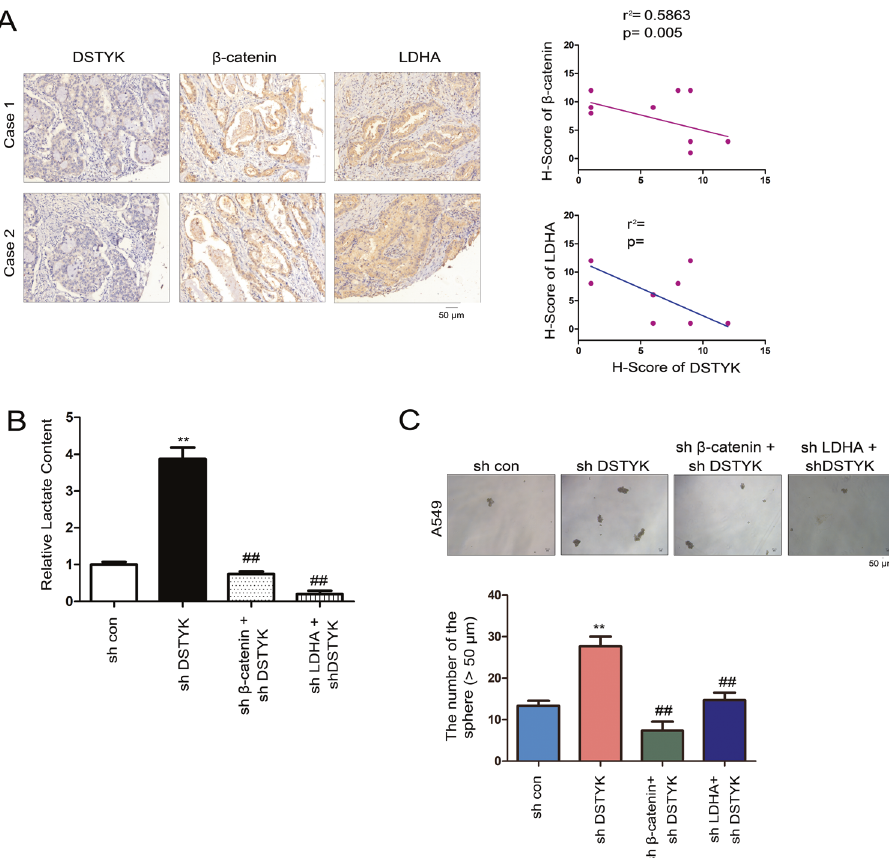
Fig. 7 DSTYK/Wnt/ β -catenin signaling regulated LDHA expression. A The correlation between DSTYK, β -catenin and LDHA in clinical lung tissues. The protein levels of DSTYK, β -catenin and LDHA in 10 lung cancer tissues were examined. The immunostaining was scored. Representative images of two cases are shown, and the correlations between the expression of DSTYK, β -catenin, and LDHA were analyzed. B Knockdown of β -catenin or LDHA abolished the elevated lactate content induced by DSTYK knockdown. ## P < 0.01; ** P < 0.01. C Knockdown of β -catenin or LDHA abolished the enhanced sphere formation induced by DSTYK knockdown. The sphere was counted and the statistical analysis was performed. ** P < 0.01; ## P < 0.01. The scale bar was